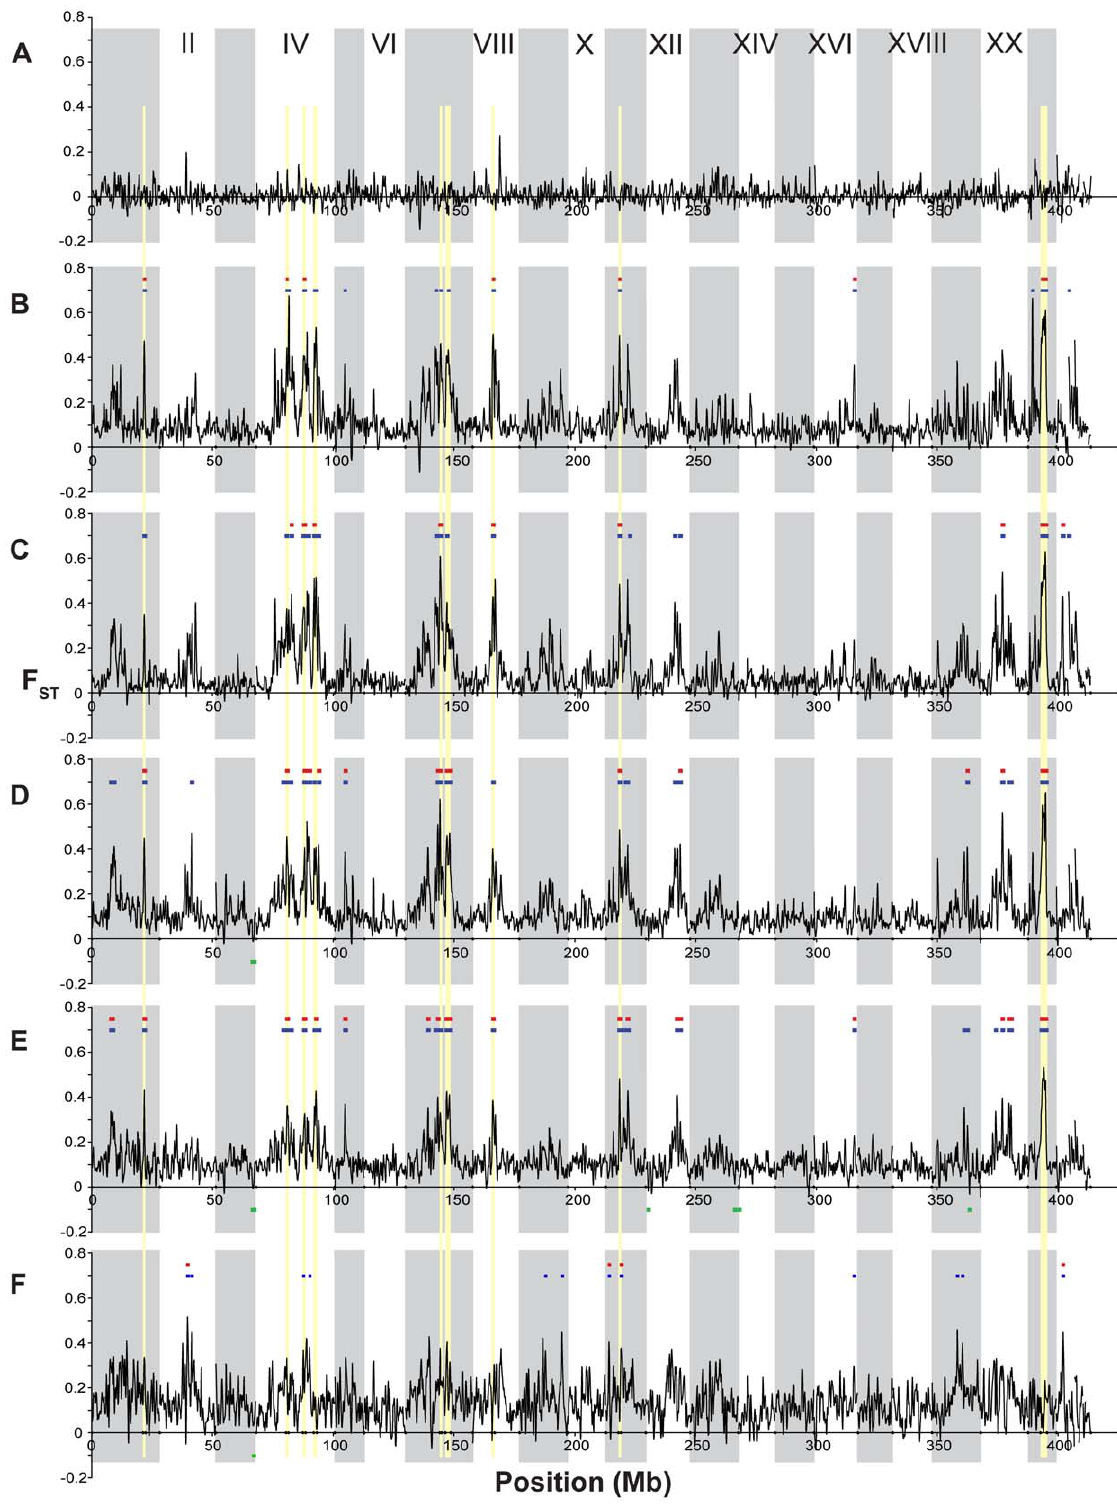
Figure 6. Genome-wide differentiation among populations. F ST across the genome, with colored bars indicating significantly elevated (p # 10 2 5 , blue; p # 10 2 7 , red) and reduced (p # 10 2 5 , green) values. Vertical gray shading indicates boundaries of the linkage groups and unassembled scaffolds, and gold shading indicates the nine peaks of substantial population differentiation discussed in the text. (A) F ST between the two oceanic populations (RS and RB; note that no regions of F ST are significantly elevated or reduced). (B,C,D) Differentiation of each single freshwater population from the two oceanic populations, shown as the mean of the two pairwise comparisons (with RS and RB): (B) BP, (C) BL, (D) ML. Colored bars in each plot represent regions where both pairwise comparisons exceeded the corresponding significance threshold. (E) Overall population differentiation between the oceanic and freshwater populations. (F) Differentiation among the three freshwater populations (BP, BL, ML).